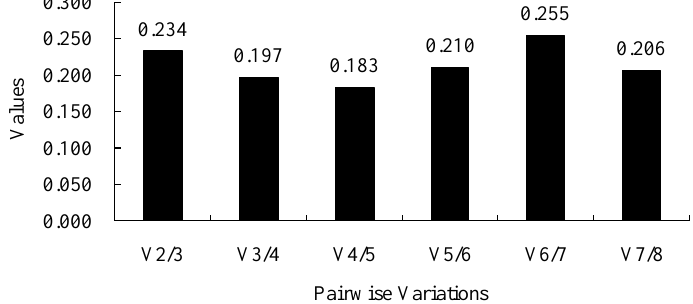
Figure 2. Evaluation of the optimum number of reference genes according to the geNorm software. The magnitude of the change in the normalization factor after the inclusion of an additional reference gene reflects the improvement obtained. V i / i+1 represent the models being compared: those with i and i + 1 reference